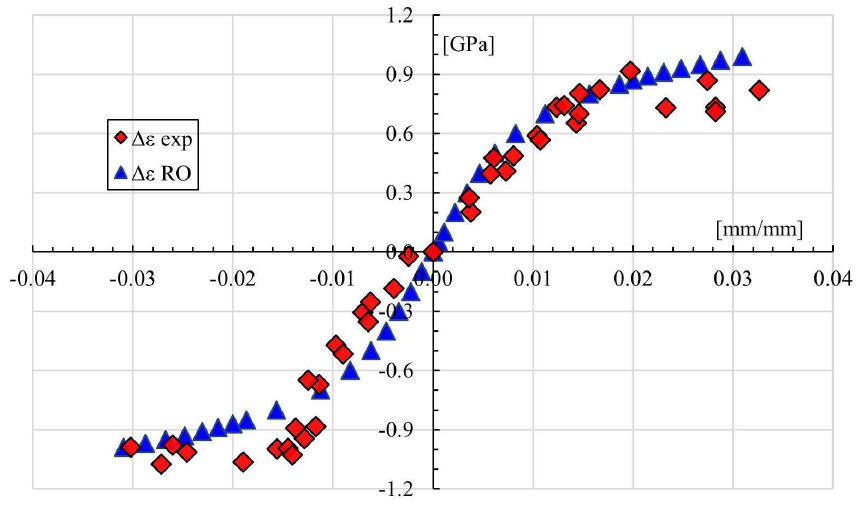
Figure 16. Dynamic stress−strain behavior.